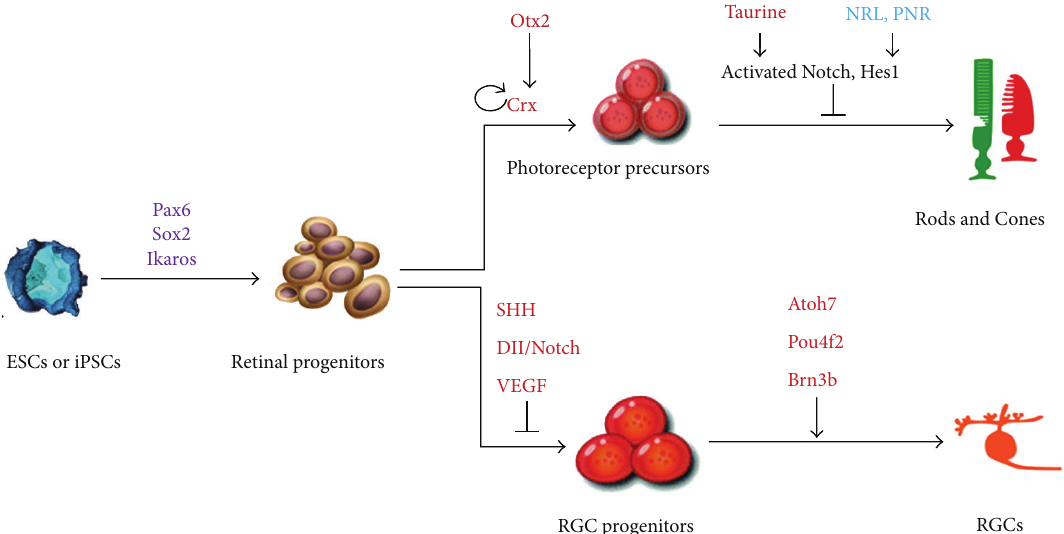
Figure 3: Schematic illustration of photoreceptor (rod and cone) or RGC production from ESCs or iPSCs. Pax6, paired box protein Pax-6; Sox2,SRY-(sexdeterminingregionY-)box2;Ikaros,Ikarostranscriptionfactor;Otx2,orthodenticlehomeobox2;CRX,cone-rodhomeobox; NRL, neural retina leucine zipper gene; PNR, photoreceptor cell-specificnuclear receptor; Hes1, hes family BHLH transcription factor 1; SHH, sonic hedgehog; DII, the drosophila distal-less; VEGF, vascular endothelial growth factor; Atoh7, atonal BHLH transcription factor 7; Pou4f2, POU domain, class 4, transcription factor